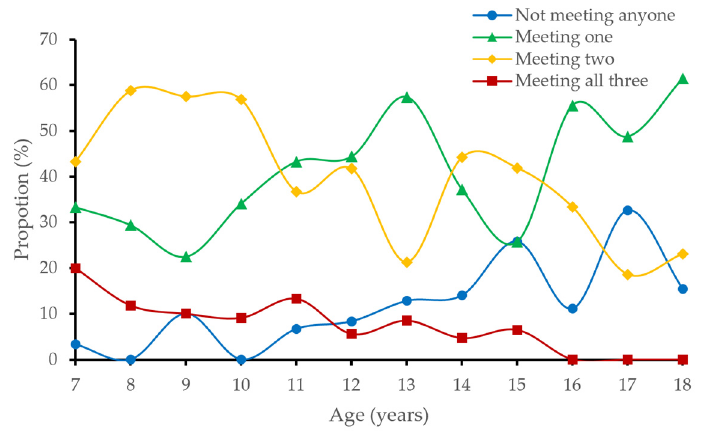
Figure 3. Proportions of Chinese children and adolescents aged 7–18 meeting 0, 1, 2, or 3 of the 24-Hour Movement Guidelines.